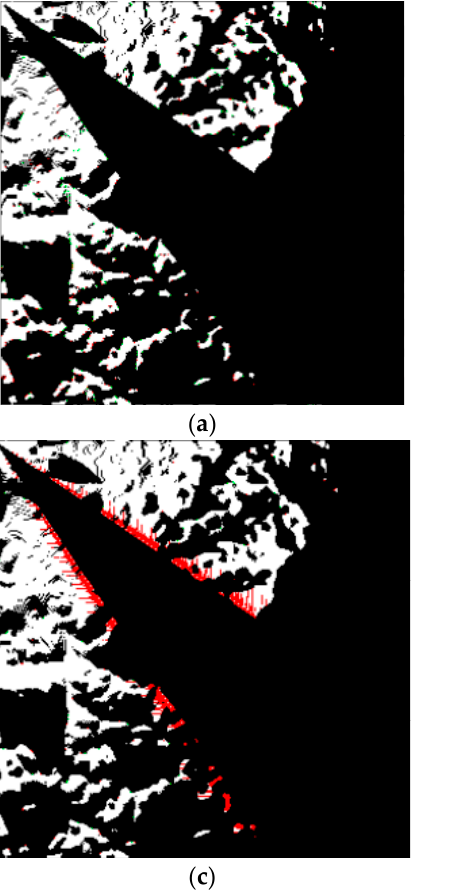
Figure 11. Partial viewsheds under the influence of a pillar corresponding to the green rectangle in Figure 9. The pillar of 999 meters high is placed at (2, 2) southeast to the viewpoint. These viewsheds are generated by ( a ) R2, ( b ) XDraw, ( c ) 10-BT and ( d ) HiXDraw, respectively. Red means visible areas are wrongly determined as invisible and green means invisible areas are wrongly determined as